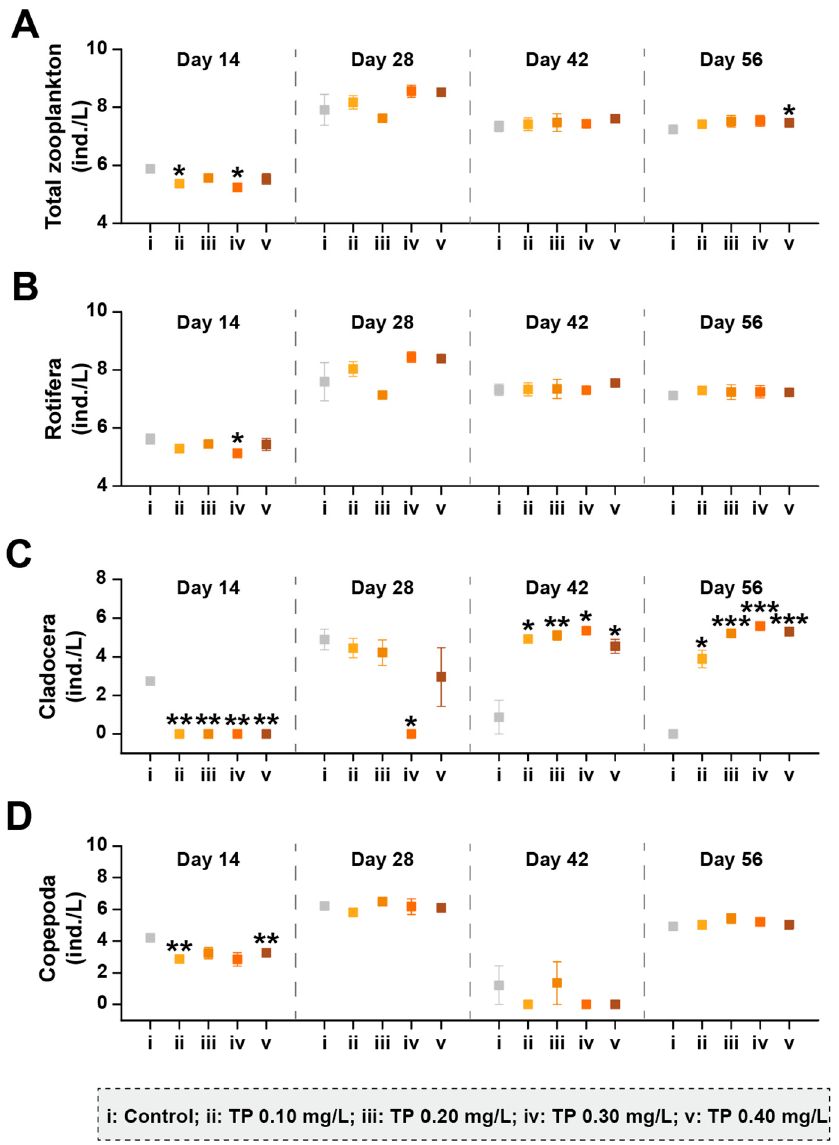
Figure 4. The abundances of zooplankton taxa groups under different TP concentrations. ( A – D ) represents the abundance of total zooplankton, Rotifera, Cladocera, and Copepoda, respectively. The abundance data were ln(ax+1) transformed. Significant differences are indicated in the figure, p ≤ 0.05 is marked as *, p ≤ 0.01 is marked as **, and p ≤ 0.001 is marked as ***.